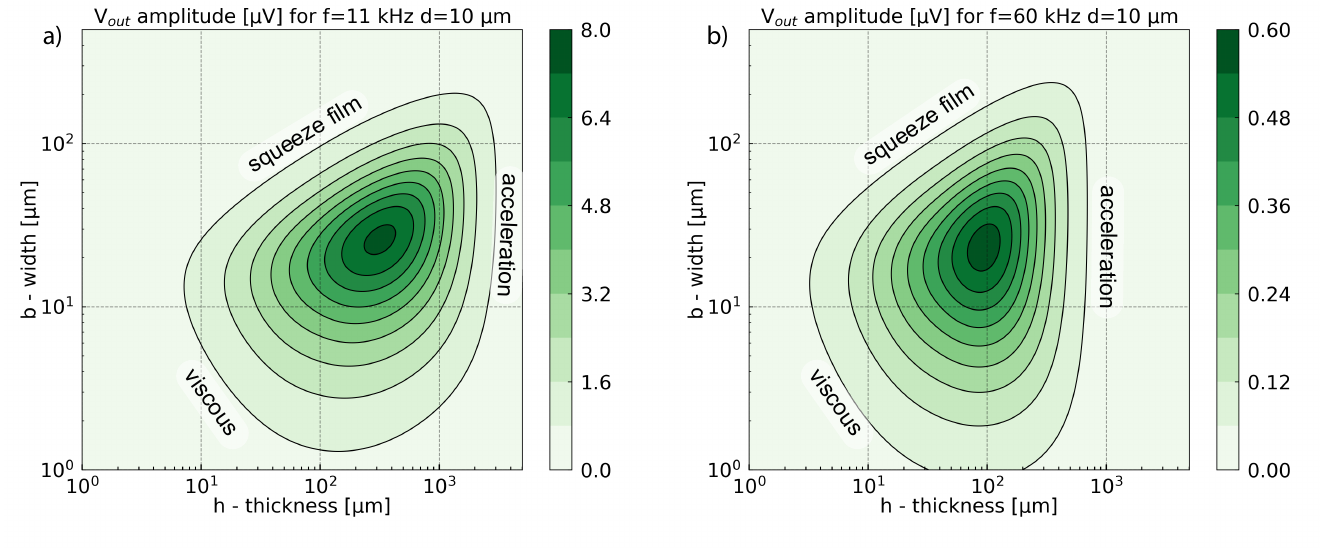
Figure 9. Amplitude of the output voltage versus width and thickness for a cantilever of fundamental resonance frequency equal to 11 kHz ( a ) and 60 kHz ( b ) for a gap between the support and the cantilever equal to d = 10 µ m. The polarization voltage is V dc = 1